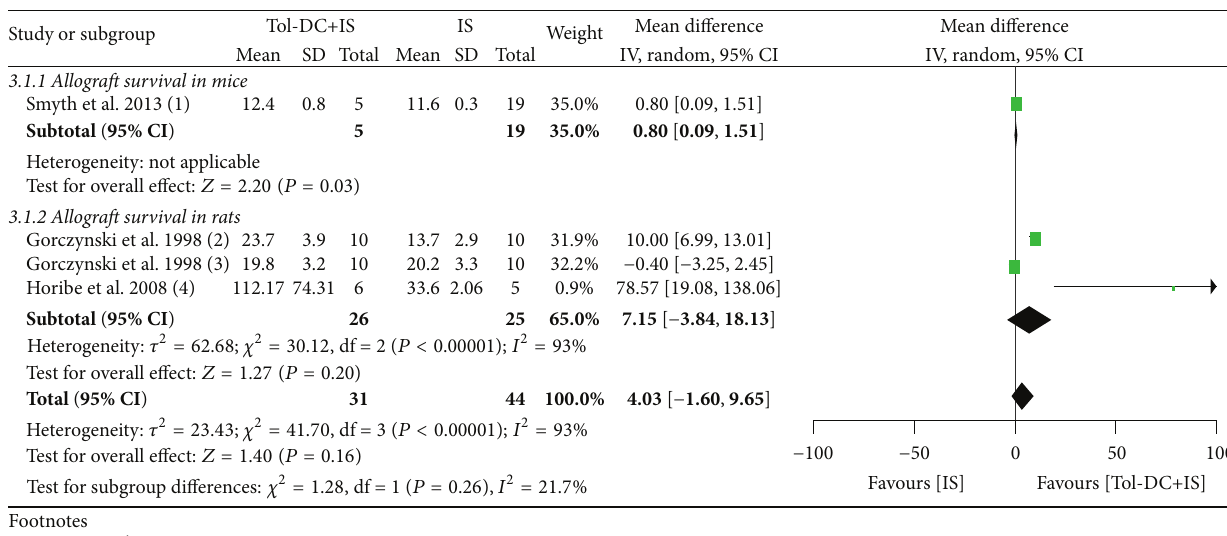
Figure 5: Mean difference (95% confidence intervals) for Tol-DC in combination with IS versus IS alone for allografts survival in heart (a), small intestine (b), islet (c), and skin (d) transplantation models. Rats used in study Gorczynski 1998 [8] in small intestine and skin models were MHC semimismatch. In the footnotes, “ − ” before “DC” means genetic modification and “+” inside the parentheses means substances added in the culture medium and “+” outside the parentheses means combined IS agents. If not specialized, DC refers to donor bone borrow